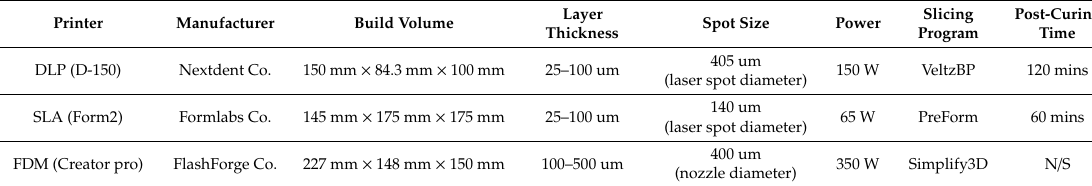
Table 1. Specifications of 3D printing devices.